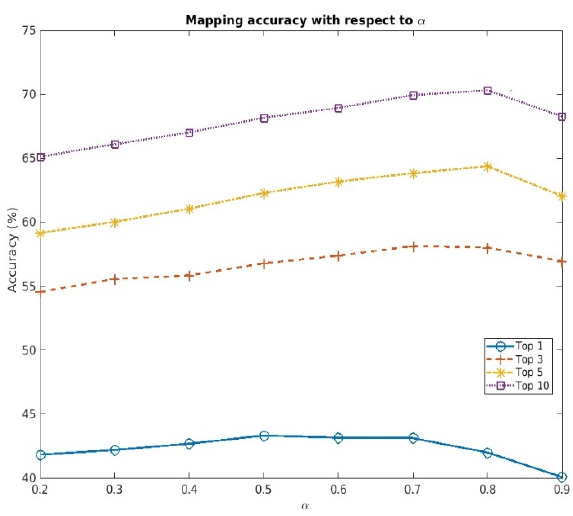
Figure 2. Changes in the mapping accuracy of MARIE (BioBERT + R / O) with respect to α (target dataset with 50,000 random samples).